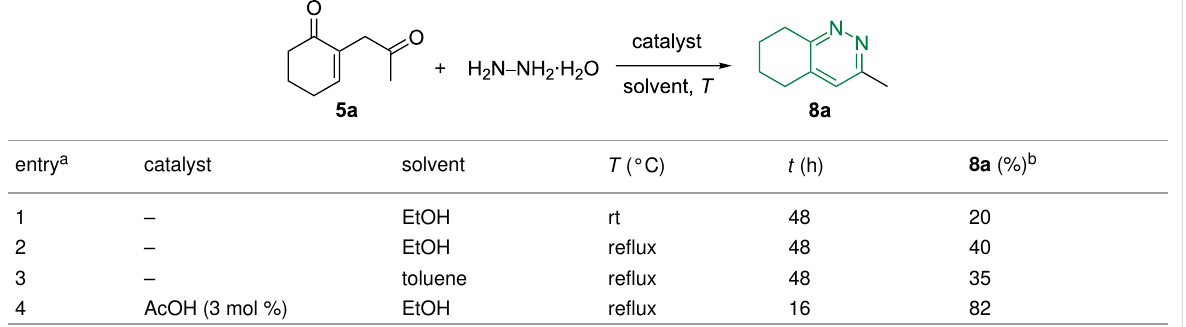
Table 2: Optimization of the reaction conditions for the synthesis of the cinnolines 8 .